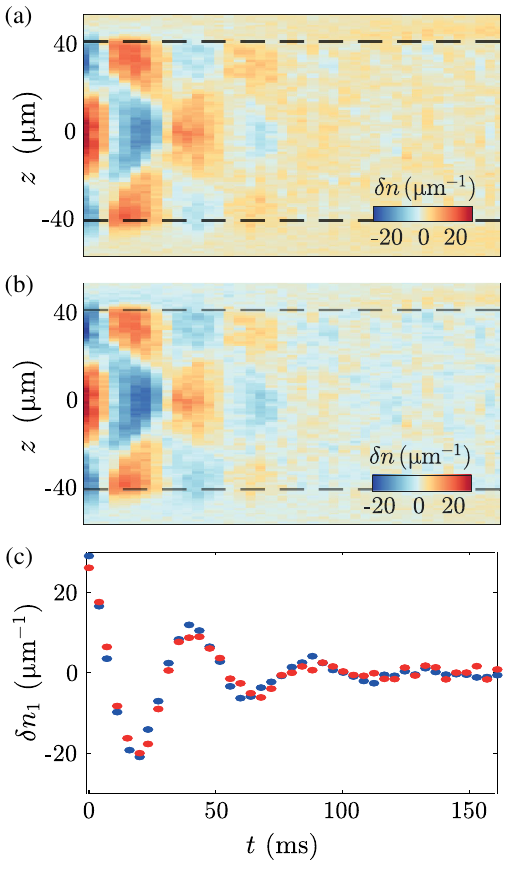
FIG. 8. Symmetry of the geometric quench. The damping does not change if the dynamics is initialized in a cosine potential or in a flat box. In this measurement, the mean atomic density is 97 μ m − 1 , and the temperature of the initial thermal state is T ¼ 152 nK. In (a) is illustrated the evolution of the density perturbation δ n ð z; t Þ after a quench from the cosine-mode potential to a flat box; in (b) the quench is reversed. Panel (c) shows the evolution of the excited mode δ n 1 ð t Þ . The blue data points correspond to the quench from single mode to flat box, while the red ones correspond to the reversed one (with flipped sign). Theoretically, the symmetry of the two quenches is easily understood since the GHD model is invariant under time-reversal